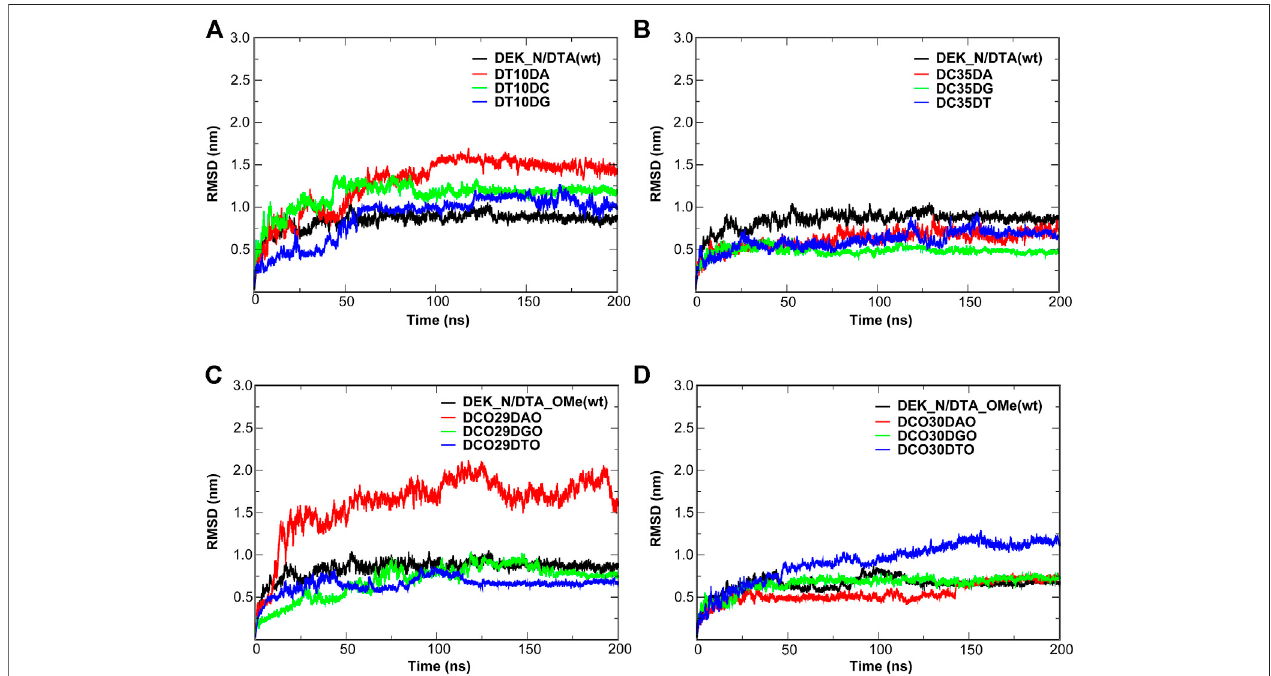
FIGURE 10 | RMSD of the wild type complexes and the corresponding mutants. (A,B) DEK_N/DTA complex and its mutants. (C,D) DEK_N/DTA_OMe complex and it